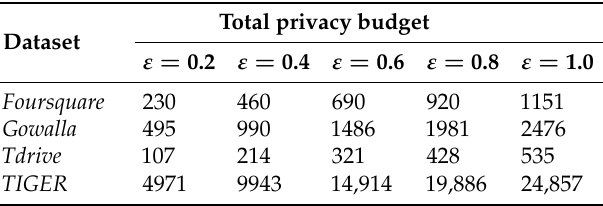
Table 3. s and f values of SAGA used in each dataset ( s = f